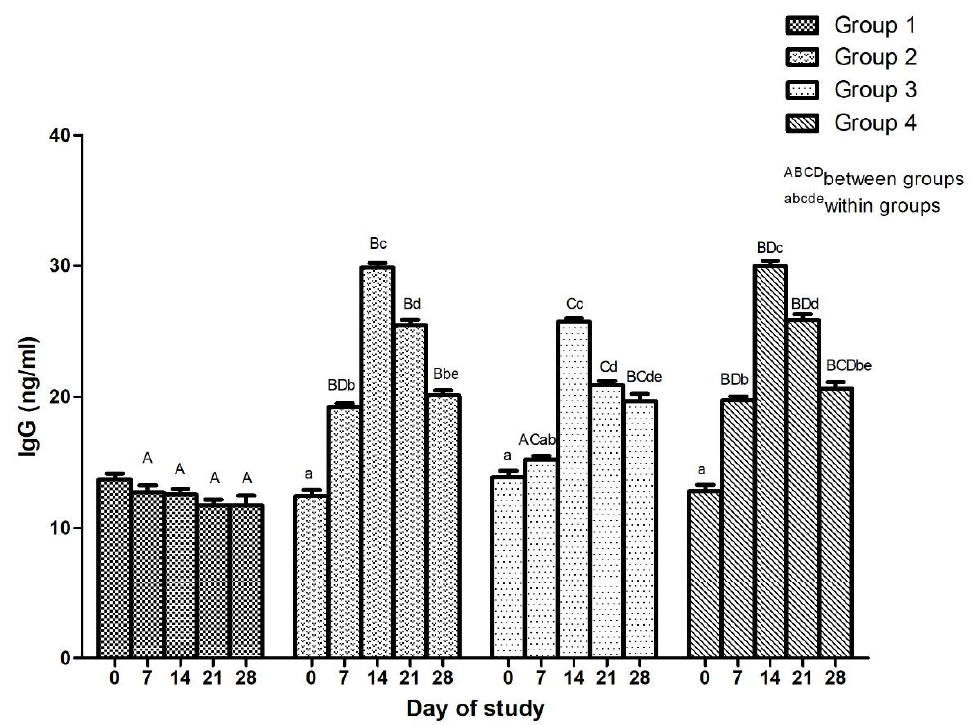
Figure 5. Effect of adjuvanted, sonicated antigens on immunoglobulin G (IgG) levels (ng/mL) in rabbits.